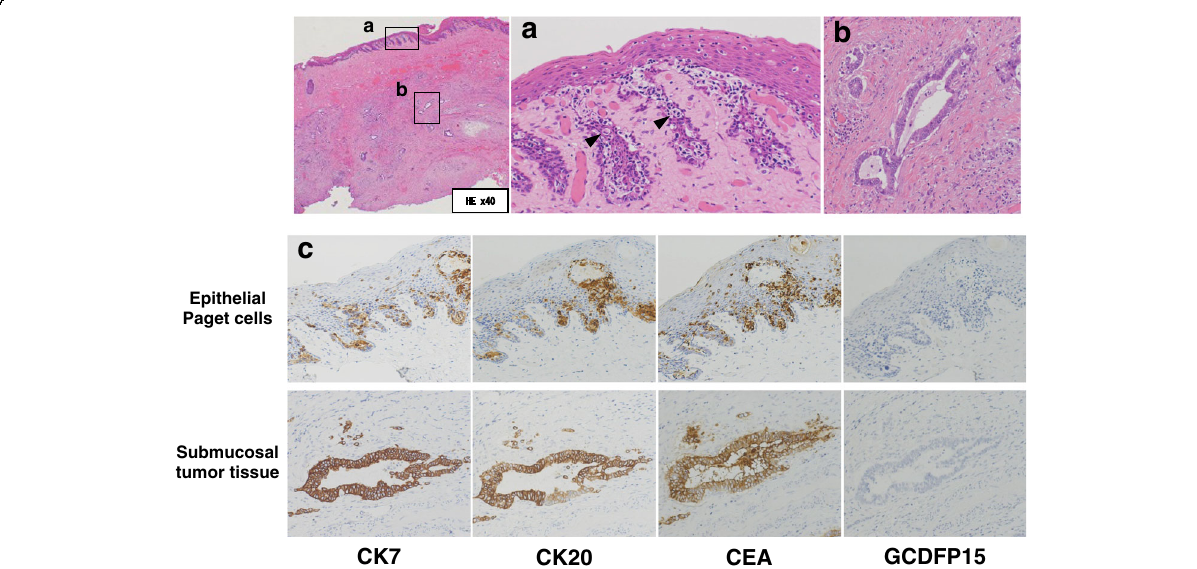
Fig. 2 Paget cells were scattered in squamous epithelium (arrow head) ( a ) (HE ×200). Adenocarcinoma tissue was observed in the submucosa ( b ) (HE, ×200). Immunohistochemical staining revealed that CK7, CK20, and CEA expression was positive in epithelial Paget cells and submucosal adenocarcinoma tissues. However, GCDFP-15 activity was not detected in any lesions ( c )